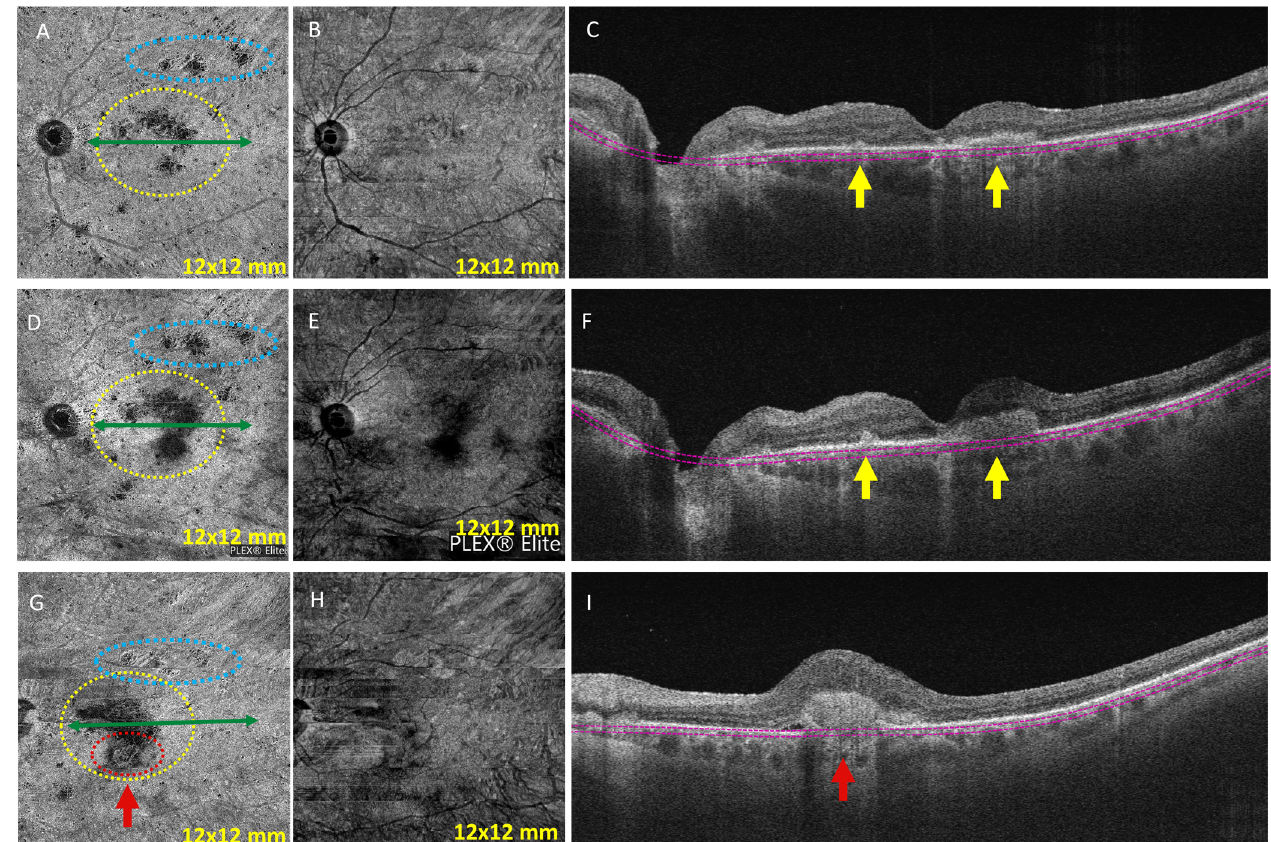
Figure 4. Case number 4: Multifocal choroiditis and secondary inflammatory neovascularization. ( A ) Plex Elite OCTA (12 mm × 12 mm) showed multiple lesions that presented as “non-detectable flow signal” at the posterior pole at the level of choriocapillaris in the left eye (lesions into yellow and blue circles). ( B ) The structure en face confirms that this is not shadow, that it is choriocapillaris non-perfusion with preserved reflectivity. ( C ) Corresponding SD-OCT showed multi-inflammatory RPE and choriocapillaris lesions in the left eye (yellow arrows). ( D ) Zeiss PLEX ® Elite 9000 OCTA (12 mm × 12 mm) performed 3 months after initial adalimumab injection (subcutaneous every 2 weeks) and after tapering a course of oral steroids showed larger areas of non-detectable flow signal (yellow and blue circles). ( E ) Structure en face uninterpretable. ( F ) Corresponding SD-OCT showed multiple more highly elevated inflammatory RPE and choriocapillaris lesions in the left eye (yellow arrows). ( G ) Four months after the initial adalimumab injection (s/p 3 adalimumab injections weekly), the non-detectable flow signal area in the yellow circle is still visible but with a new dense inflammatory secondary neovascularization at the bottom of the lesion (red circle). ( H ) Structure en face uninterpretable. ( I ) Corresponding SD-OCT showed higher inflammatory secondary neovascularization as subretinal hyperreflective material (red arrow) with a small amount of subretinal fluid in the left eye. Manual segmentation used for boundaries in OCT (pink lines in images ( C , F , I )).